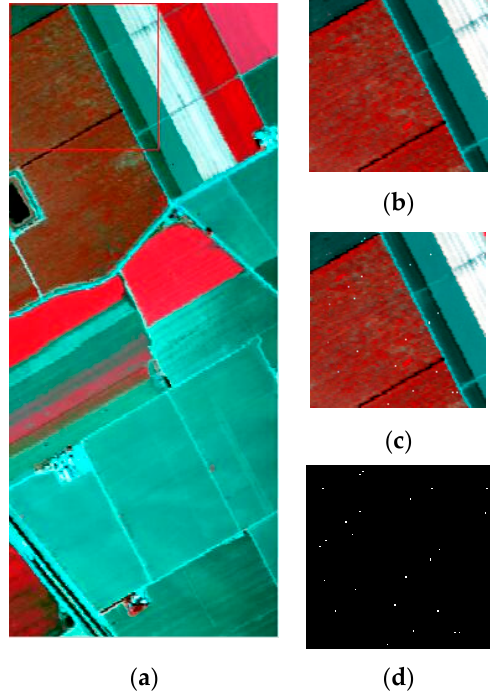
Figure 3. AVIRSI_Salinas dataset: ( a ) false-color image of the whole scene (R:65, G:33, B:21); ( b ) false-color image of the subarea; ( c ) false-color image of the synthetic; ( d ) the anomaly location map.